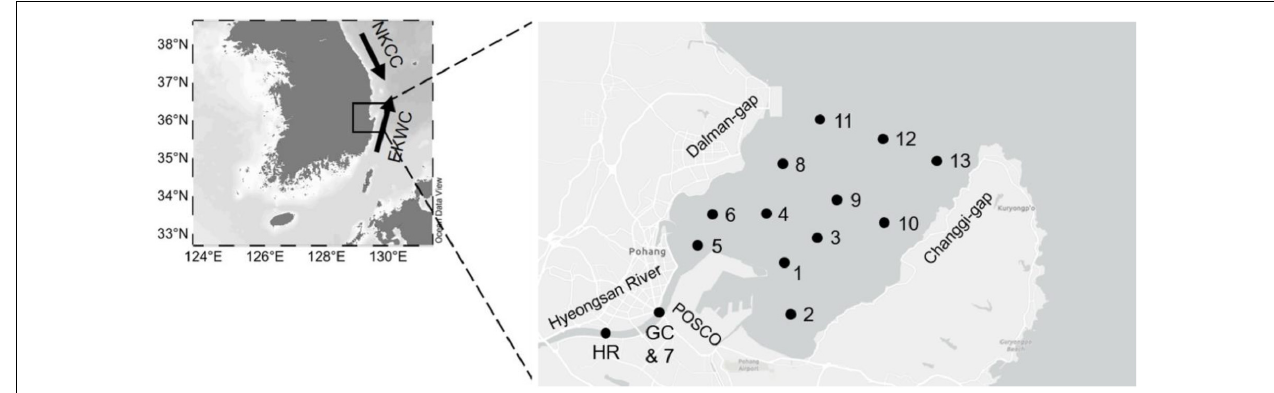
FIGURE 1 | Station maps showing the location of the Yeongil Bay on the southeastern coast of Korea. Black dots indicate the sample stations. HR and GC are locations where total nitrogen samples were collected. HR, Hyeongsan River; GC, Gumu Creek; POSCO, Pohang Iron and Steel Company; NKCC, North Korea Cold Current; EKWC, East Korea Warm Current. Phytoplankton samples were collected by the Marine Eco-Technology Institute and environmental data were obtained from the Marine Environmental Information System (www.meis.go.kr).